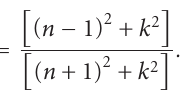
Figure 5: The variation of refractive index ( n ) versus di ff erent concentrations of PVAc in (PMMA/PVAc) blends without exposure to radiation at wavelength of 200